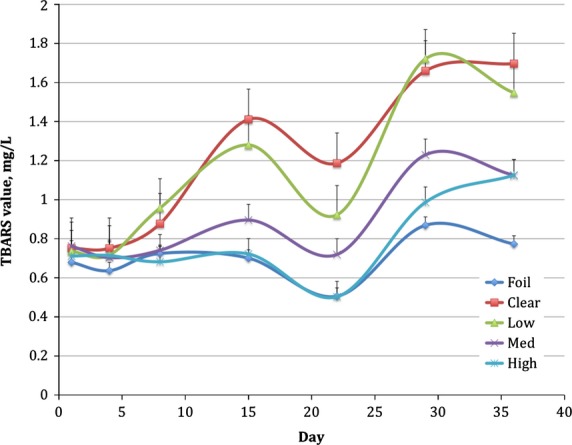
TBARS values in packaging treatments, Low (0.6% TiO2), Med (1.3% TiO2), and High (4.3% TiO2), compared to foil-wrapped and clear packaging over a 36-day period.1 Average of data in both block A and B. 1Exposure to light in hours: day 1 = 23.5, day 4 = 84, day 8 = 191, day 15 = 359, day 22 = 527, day 29 = 696, day 36 = 864